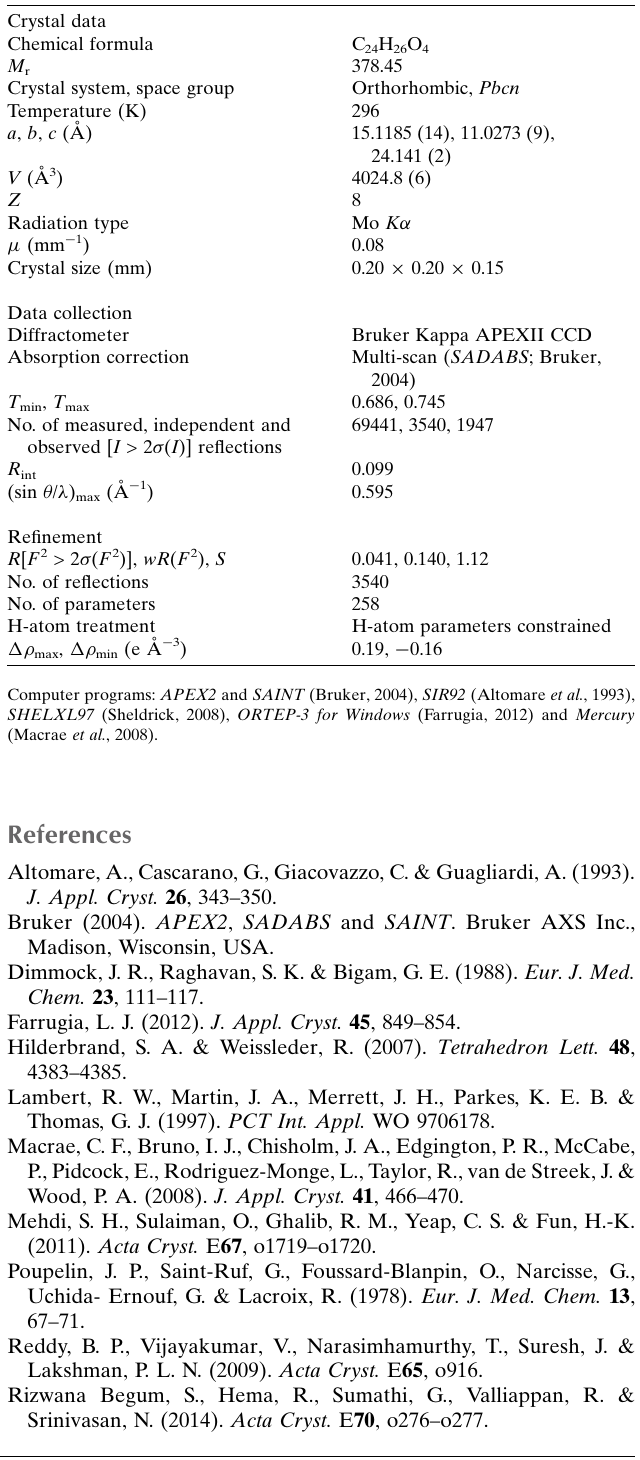
Table 2 Experimental details.